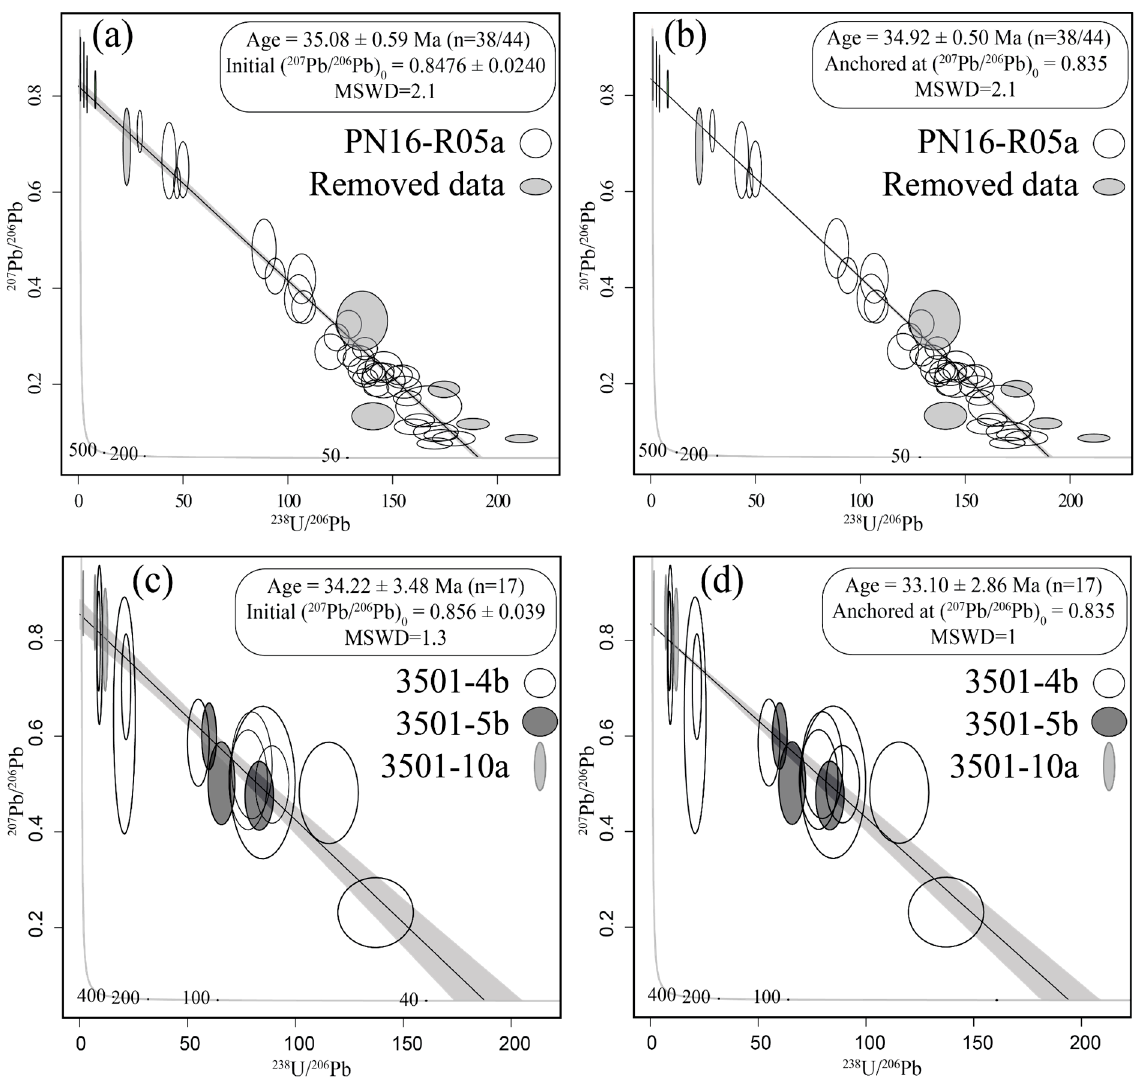
Figure 11. Tera–Wasserburg diagrams of the monazite LA-ICP-MS analysis (Table 3) for the Peisey-Nancroix ( a , b ) and the Macôt-la Plagne ( c , d ) deposits. ( a ) and ( c ) provides Discordia lines and ages calculated without any correction, whereas for ( b ) and ( d ) the initial 207 Pb/ 206 Pb ratio is fixed at 0.835, using the bulk-Pb evolution model of Stacey and Kramers [78] and Cumming and Richards [79], to correct the calculated age from the common Pb contamination. Forty-four analyses from twenty-six monazite grains (white ellipses in ( a , b )) were used for calculating the age of PN16-R05a (gray ellipses ( n = 6) were removed from the age calculation after SEM control, §4.4.). Seventeen analyses from fourteen monazite grains were used for calculating the age (without removed data) from the Macôt-la Plagne samples.